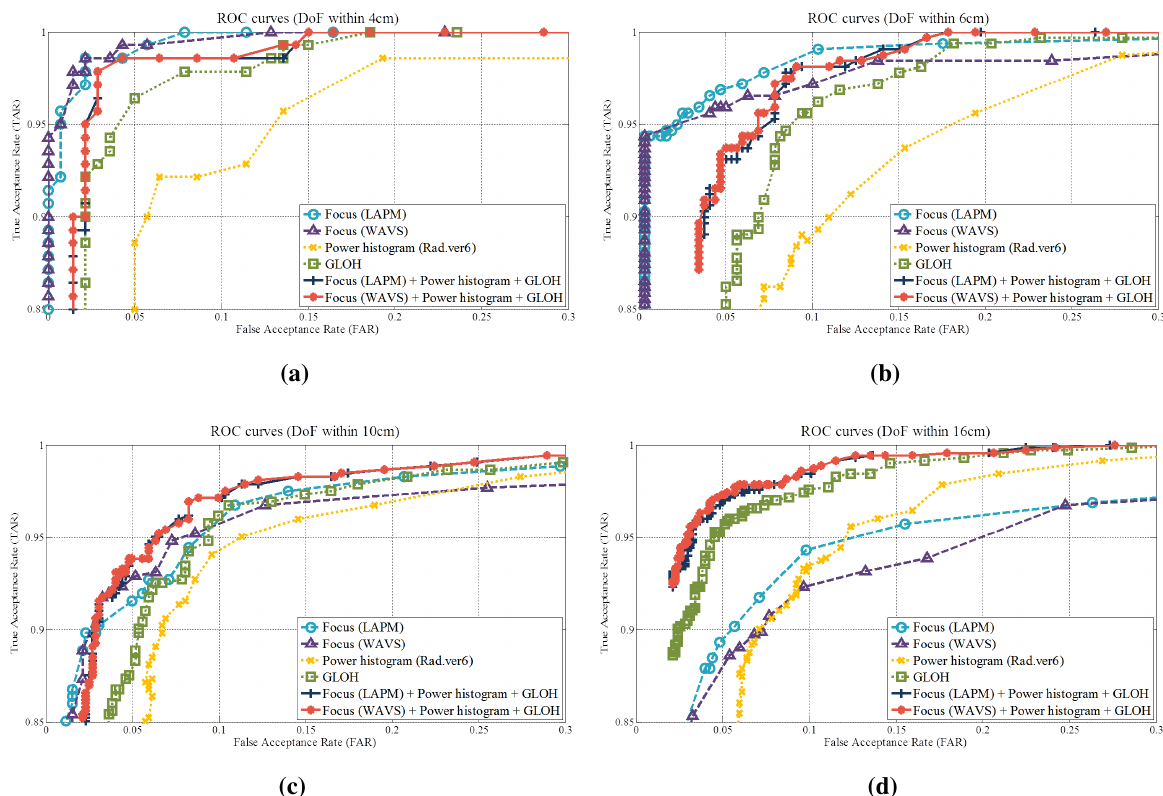
Figure 22. ROC curves of the feature-level fusion (DoF ( a ) within 4 cm, ( b ) within 6 cm, ( c ) within 10 cm and ( d ) within 16